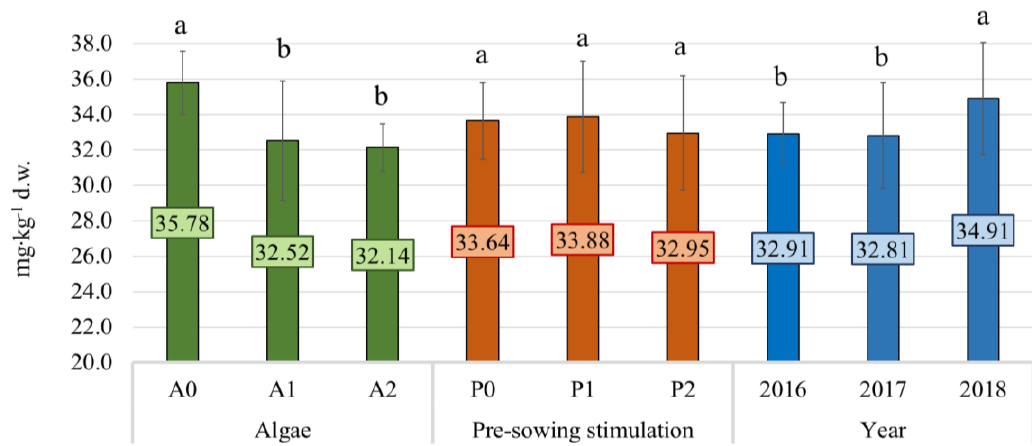
Figure 9. The mean iron content (mg · kg − 1 ) in oat grains in 2016–2018 depending on the experimental factors used. According to Tukey’s HSD test, the means marked with the same letter are not significantly different at α ≤ 0.05.